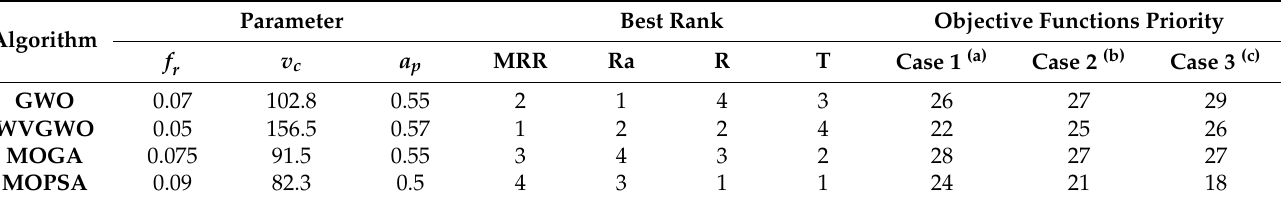
Table 7. Optimal solutions comparison of different used algorithms.